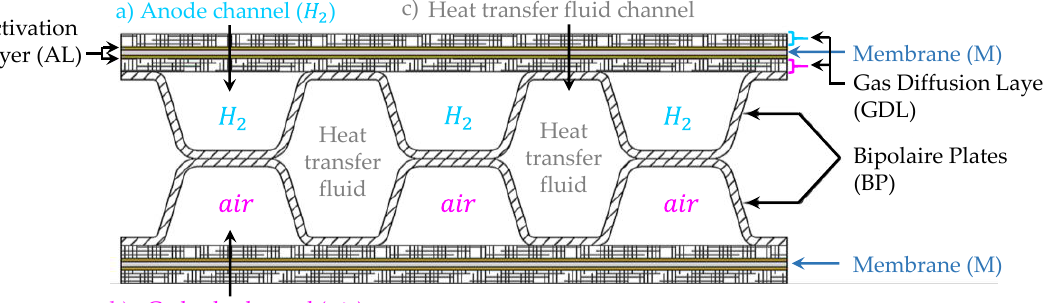
Figure 11. Section of a bipolar plate (BP) with its three channels [34]. ( a ) anode channel (H 2 ) | ( b ) cathode channel (air) | ( c ) heat transfer fluid channel.